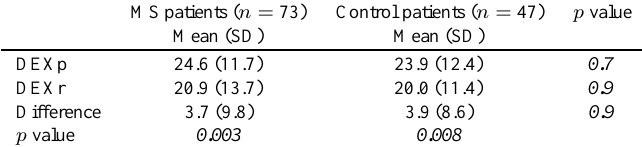
Table 4 Values for, and difference between, the two DEX total